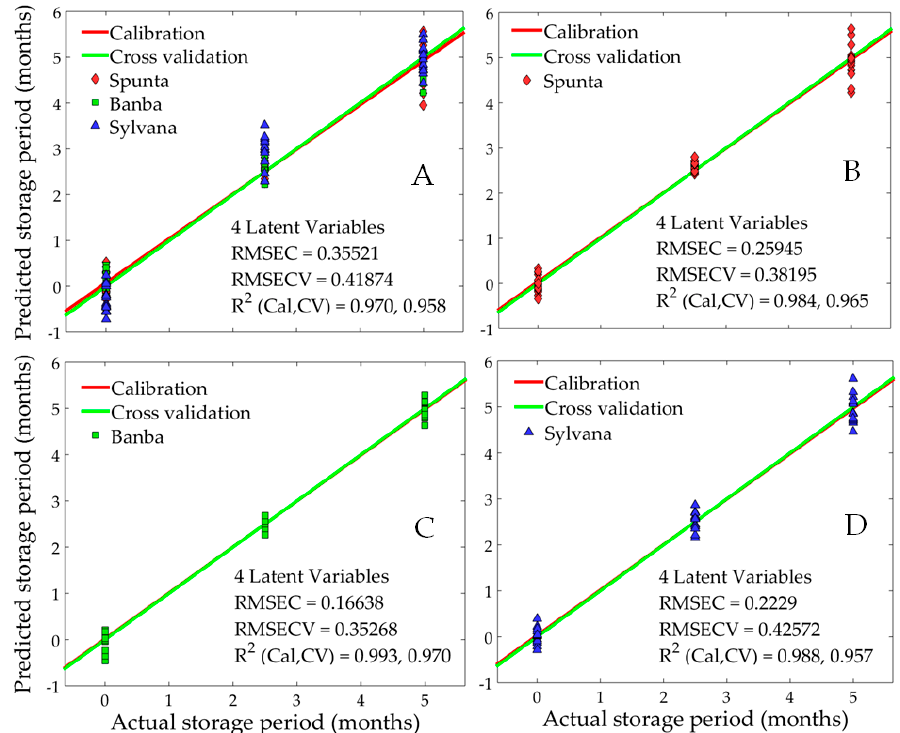
Figure 3 . Prediction of potato storage period at 5 °C based on the wavelength regions that were extracted with the genetic algorithm as a feature extraction technique of the spectra that were captured externally on the skin of the tubers from 3